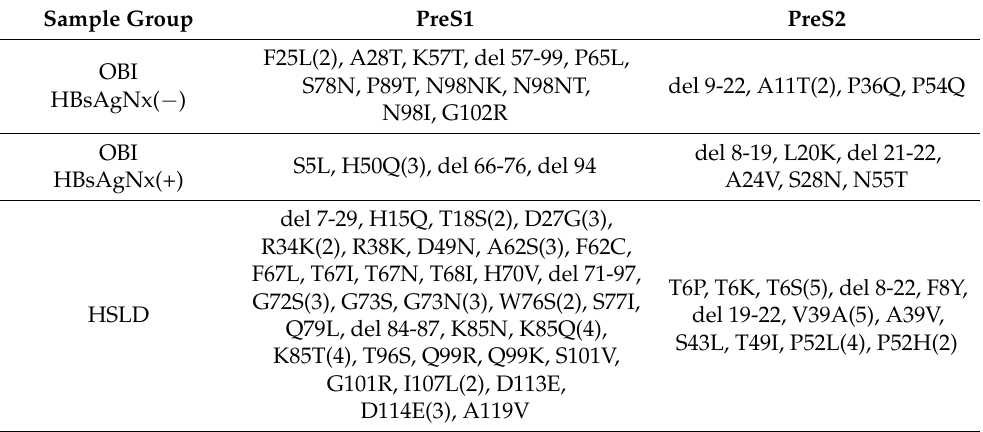
Table 5. PreS1 and PreS2 amino acid substitutions and deletions unique to OBI or HSLD